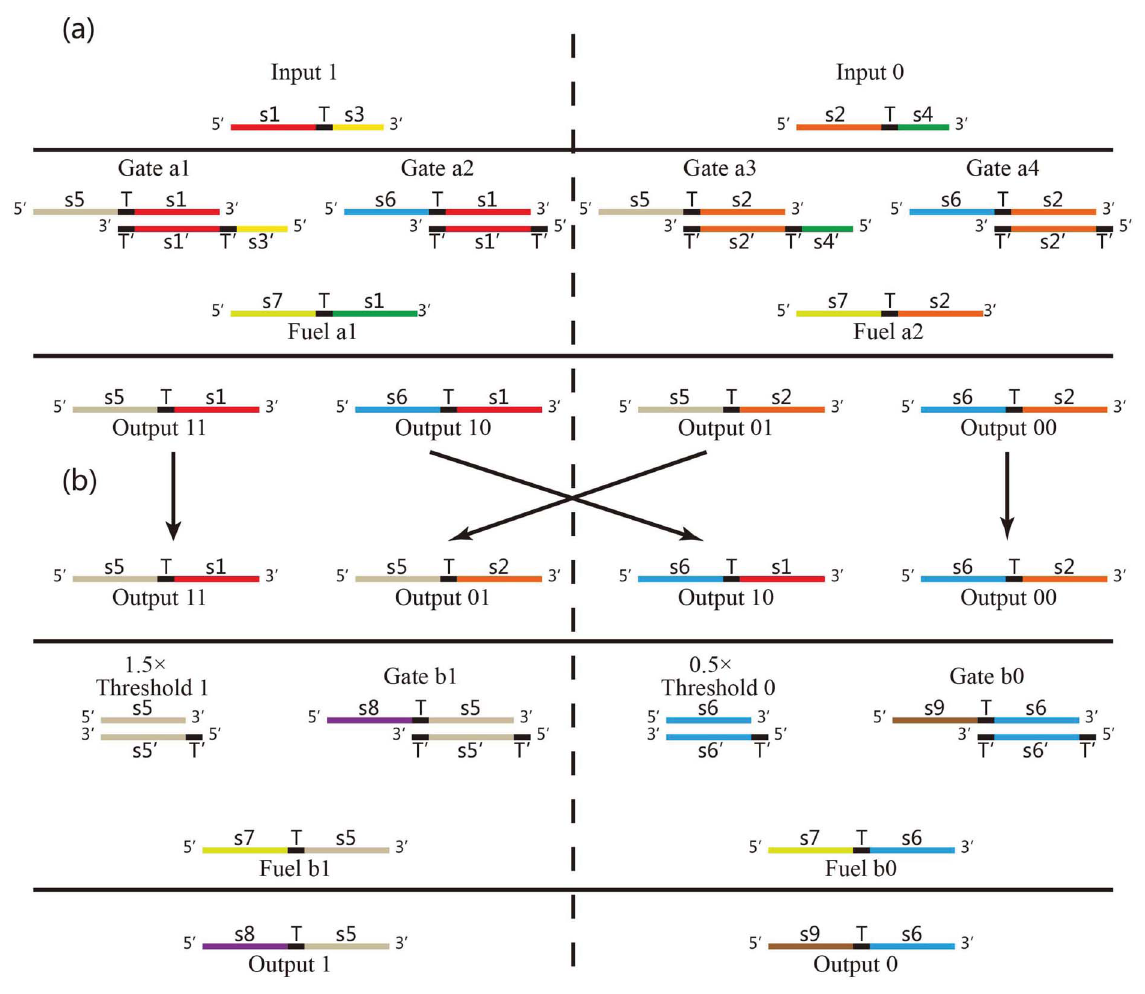
Figure 5. Abstract diagrams of two DNA neurons executing XOR logic.